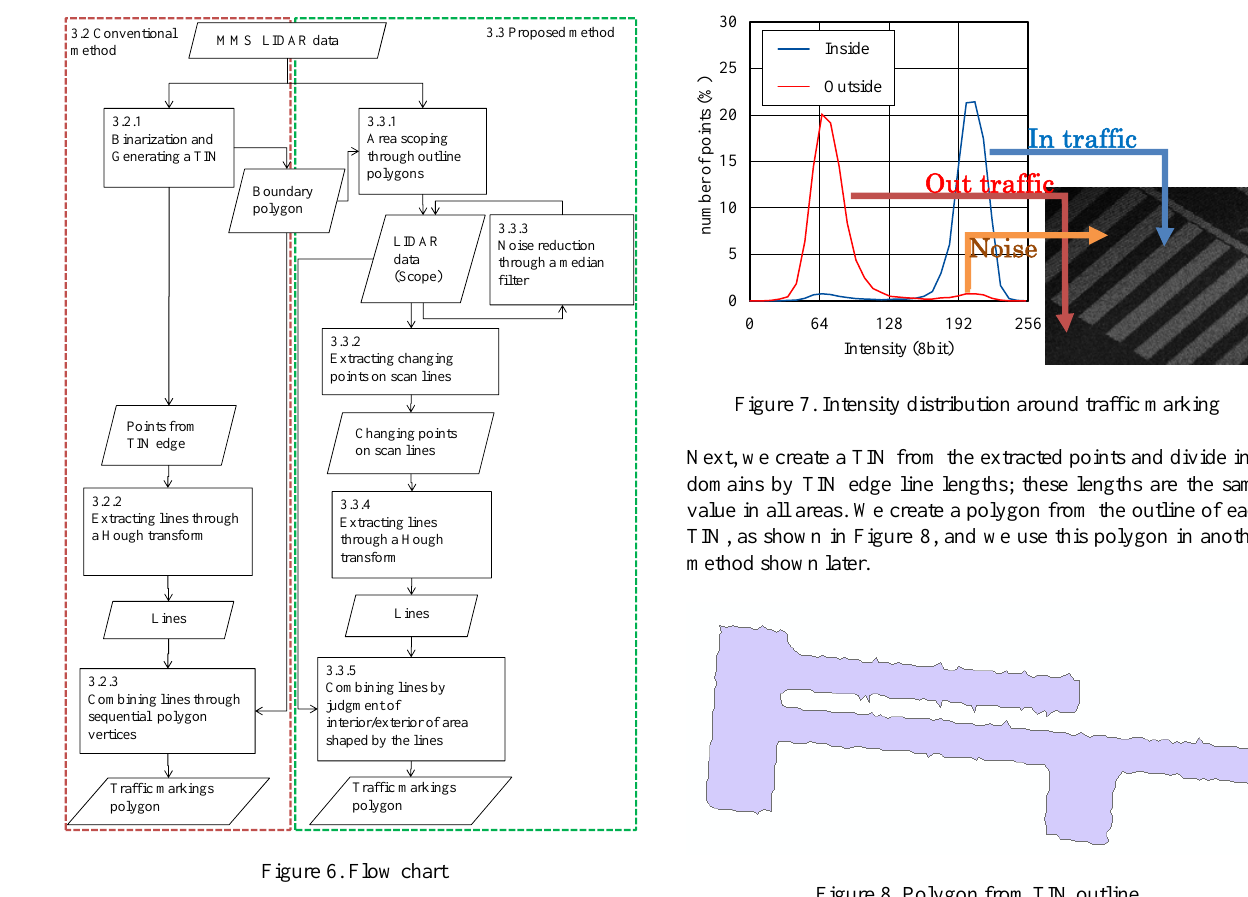
Figure 8. Polygon from TIN